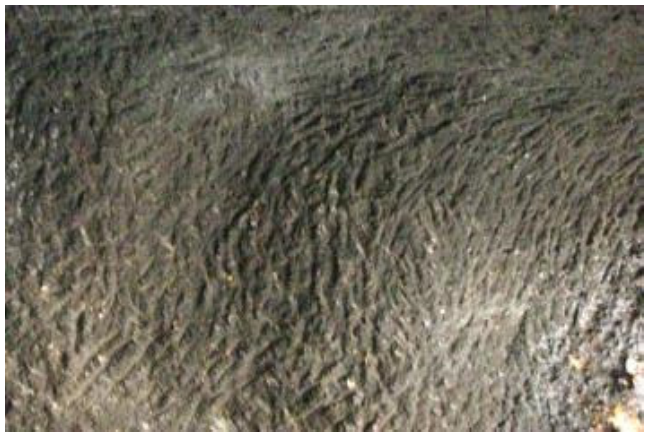
Figure 14. Fine excavation technique used in interior surface of rooms.